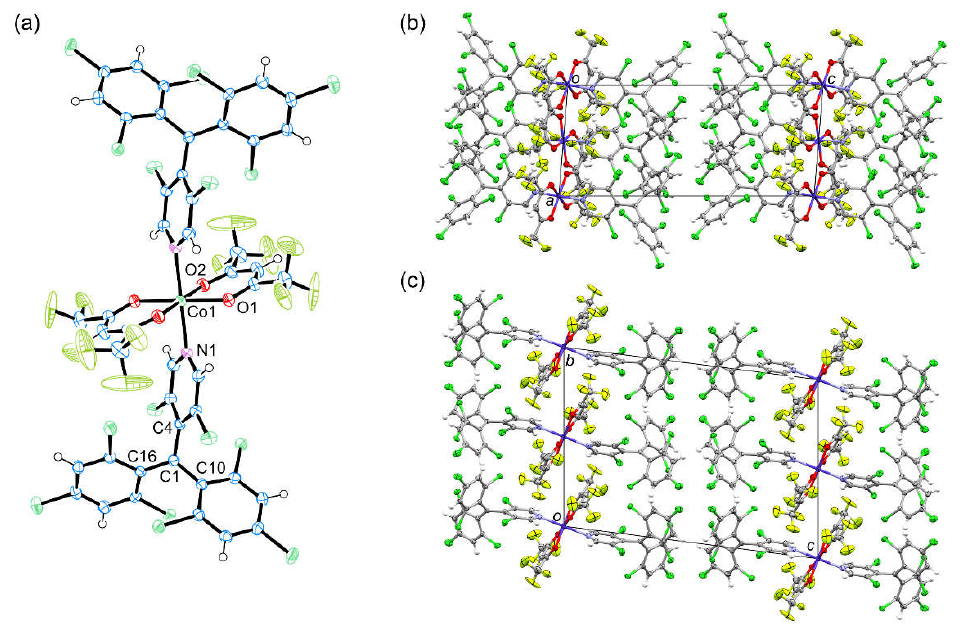
Figure 2. ( a ) Molecular structure of [Co II (hfac) 2 (PyBTM) 2 ] in the crystal. ( b ) Crystal structure viewed along the b -axis and ( c ) the a -axis. The disorder of trifluoromethyl groups is omitted for